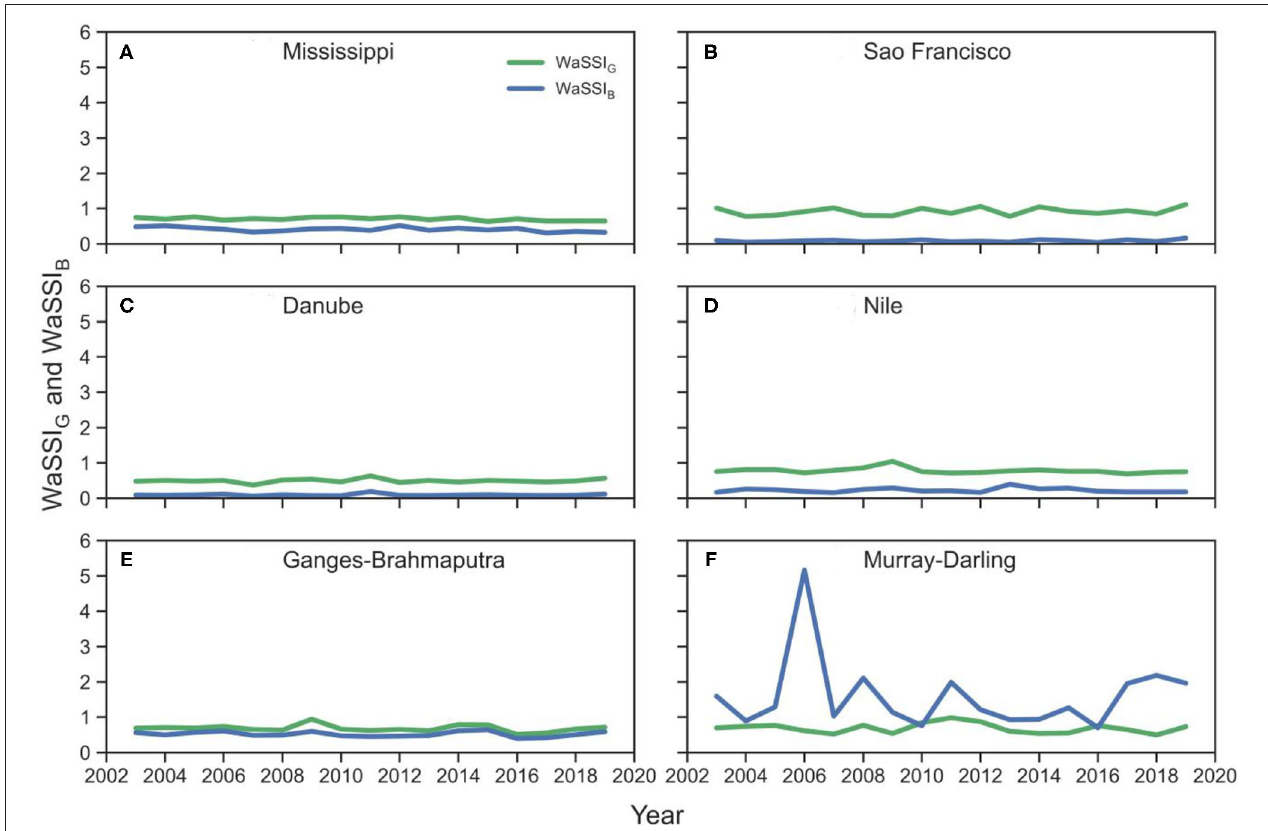
TABLE 2 | The average, minimum, maximum, and standard deviation of green (WaSSI G ) and blue (WaSSI B ) water supply stress indices of study basins from 2003 to 2019. Basin WaSSI G WaSSI B Avg. Min. Max. Std. Dev. Avg. Min. Max. Std. Dev. Mississippi 0.71 0.63 0.76 0.04 0.41 0.31 0.52